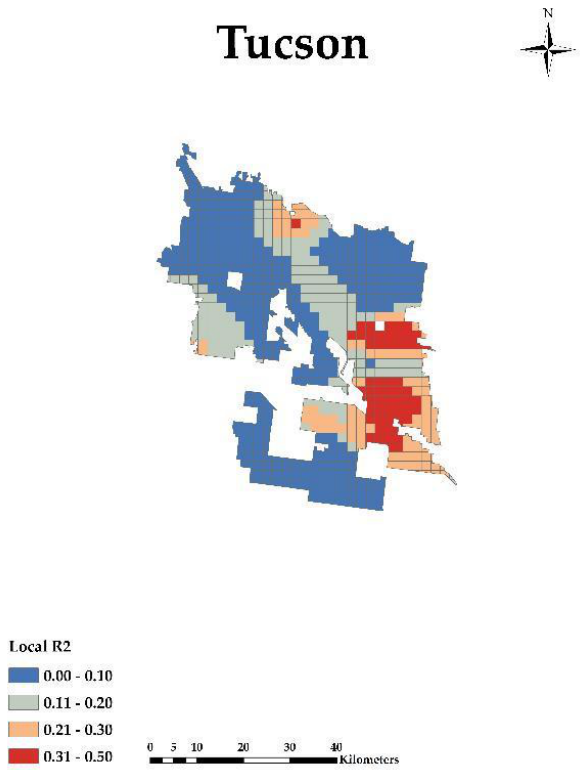
Figure 21. Tucson growing city: GWR Local r-squared.